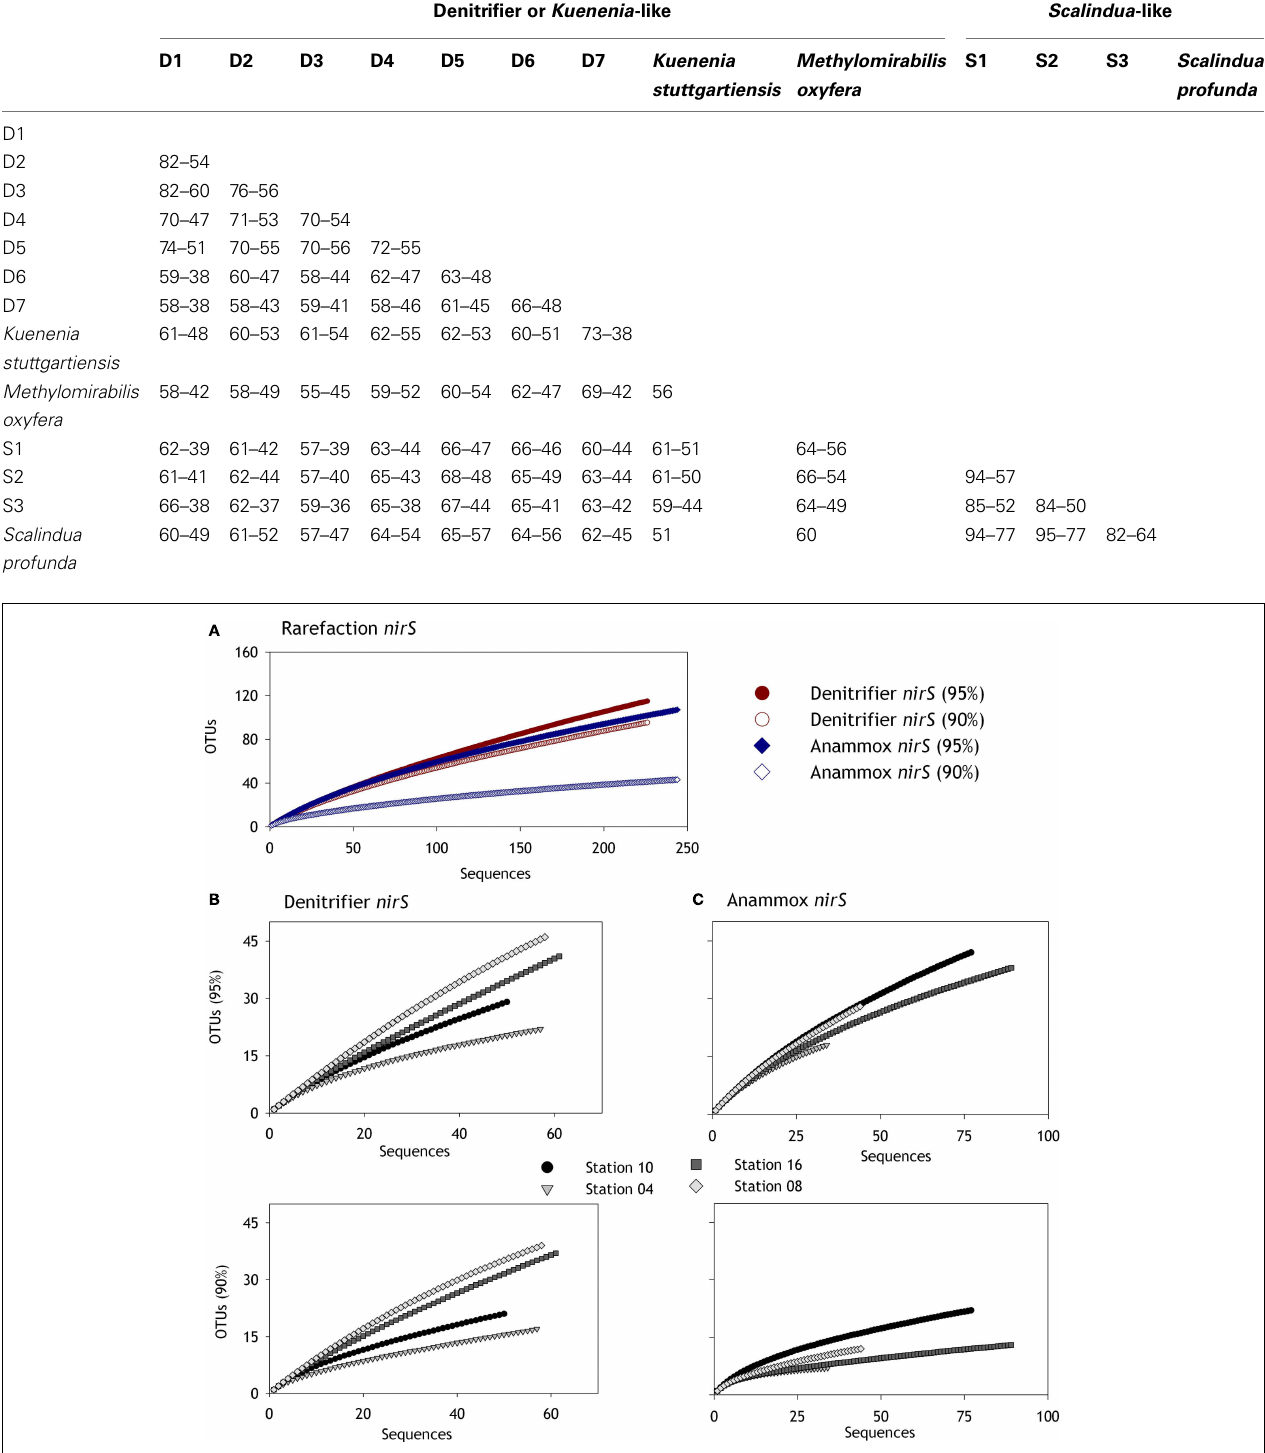
stations, (B) shows the denitrifier nirS rarefaction curves separately for each sampled station, and (C) the corresponding curves for anammox (Scalindua) nirS